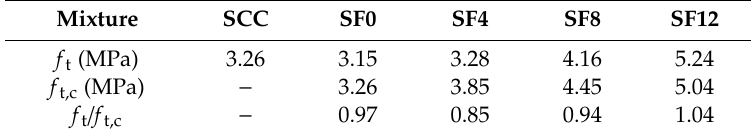
Table 8. Tested and calculated values of the splitting tensile strength of specimens. Mixture SCC SF0 SF4 SF8